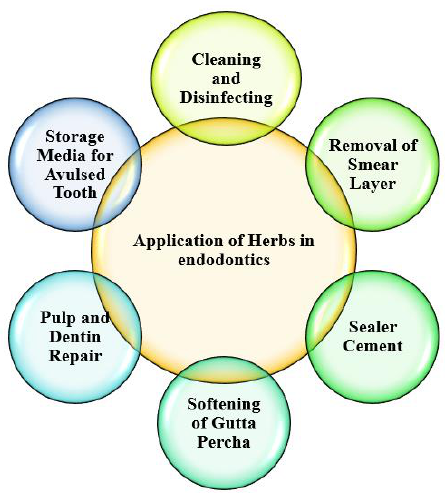
Figure 1. Application of herbs in endodontics.